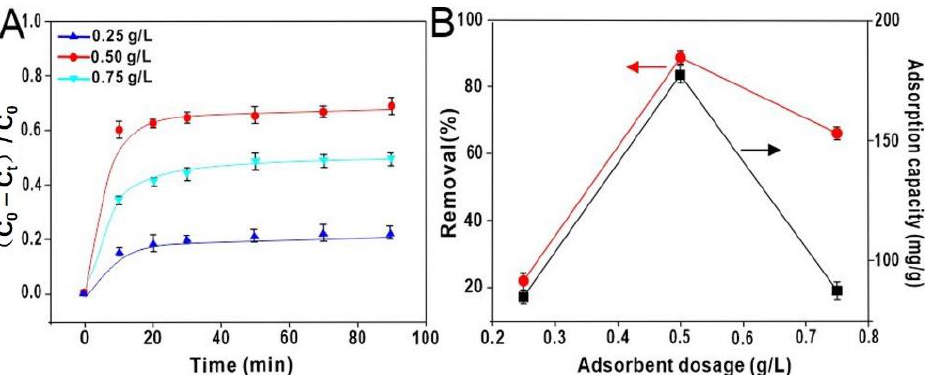
Figure 8. The effect of adsorbent dosage on Zn 2+ adsorption with an initial concentration of 100 mg/L at 25 °C ( A ). The adsorption capacity and removal of Zn 2+ on MnO 2 @PSS/PDDA/PSS with different adsorbent dosages at 25 °C ( B ).